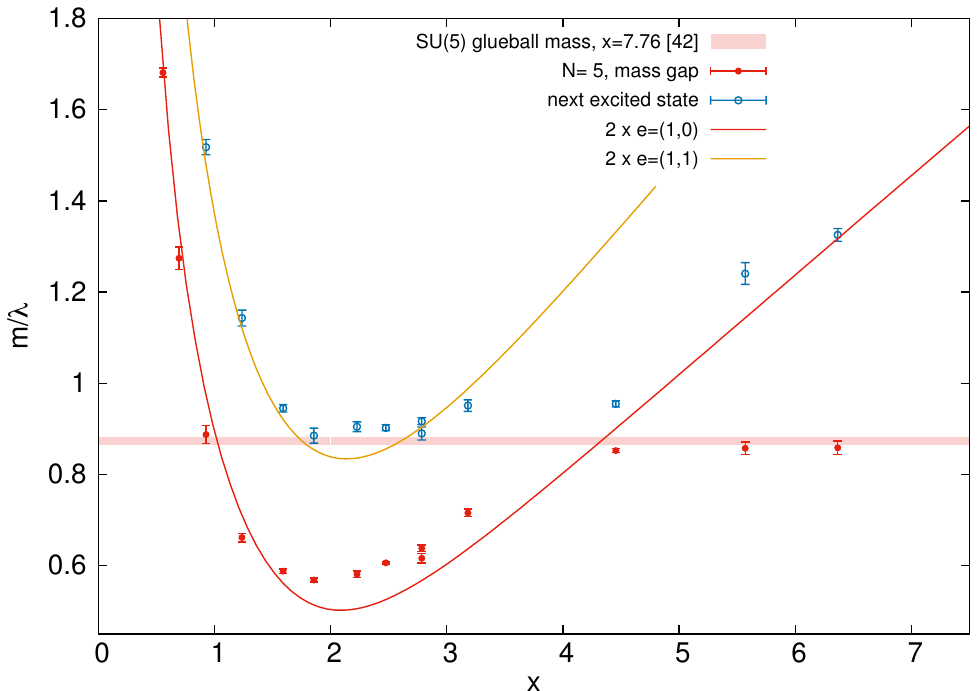
Figure 7. x -dependence of the mass gap and next excited state energy in the zero-electric (cid:13)ux sector for: f N; k g = f 5 ; 1 g . The red band is the SU(5) result of ref. [42]: m=(cid:21) = 0 : 873(8), obtained on a 32 3 lattice at x = 7 : 76. The continuous lines correspond to twice the torelon energies for the indicated electric (cid:13)uxes according to our formula